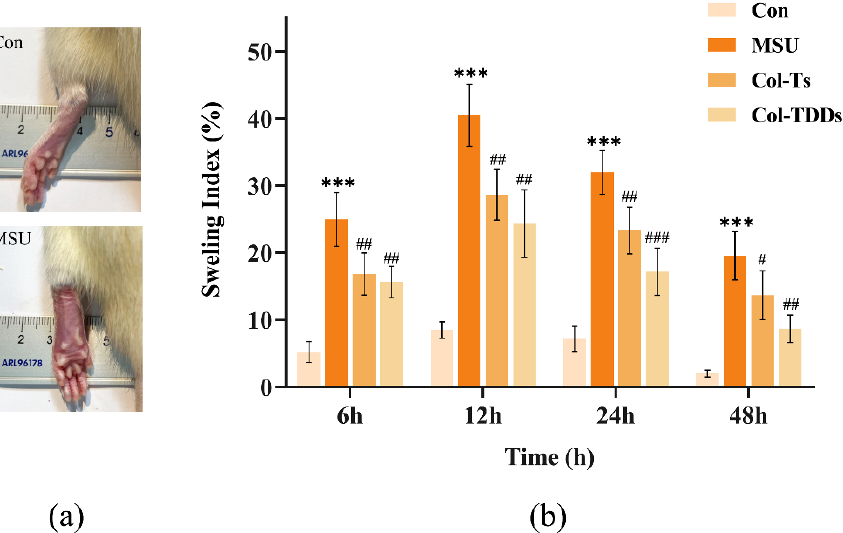
Figure 5. ( a ) Pictures of the ankle joints of rats in Con and MSU groups 12 h after injection of MSU suspension. ( b ) Effect of colchicine drug-in-adhesive patches and colchicine tablets on swelling index of the ankle in MSU-induced gout rats. Data are expressed as the mean ± SD; *** p < 0.001 vs. Con. # p < 0.05, ## p < 0.01, ### p < 0.001 vs. MSU.